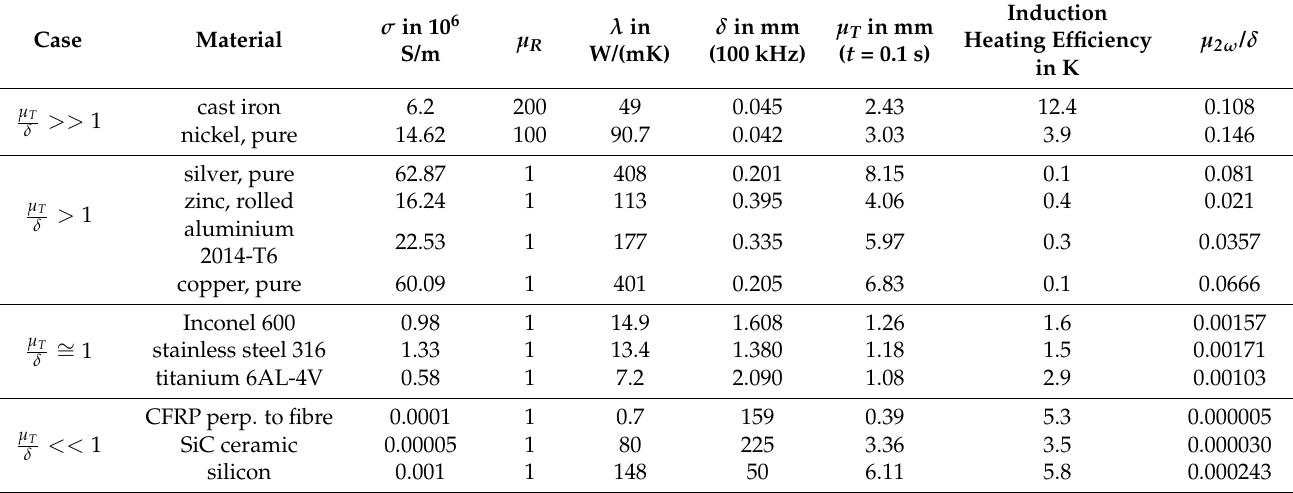
Table 1. Electrical conductivity σ , magnetic permeability µ R , thermal conductivity λ , skin depth δ at 100 kHz, thermal penetration depth µ T at 0.1 s, induction heating efficiency (the surface temperature rise in K after 0.1 s heating with 0.02 T induction field amplitude at 100 kHz), and ratio of thermal diffusion length to skin depth µ 2 ω / δ for selected